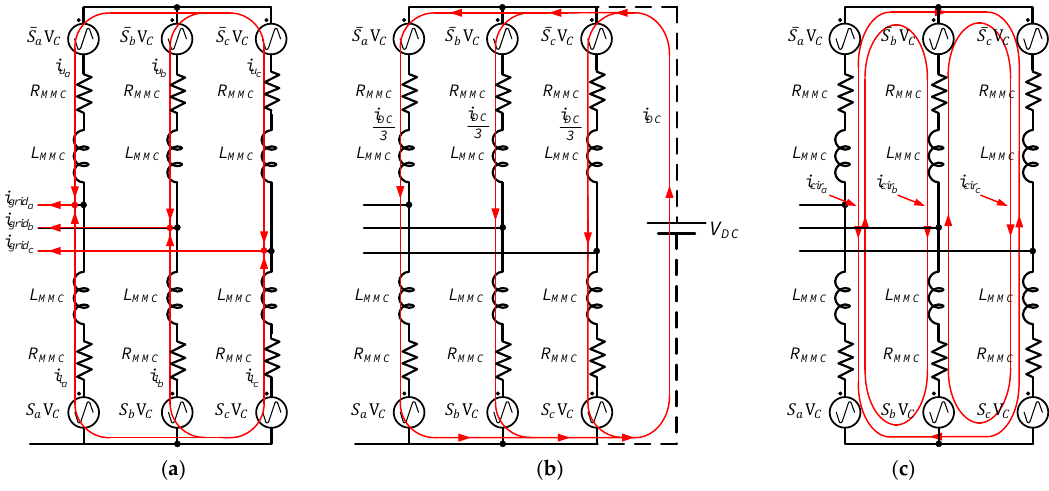
Figure 3. ( a ) Grid current and arm current; ( b ) DC current panel; and ( c ) Circulating current.